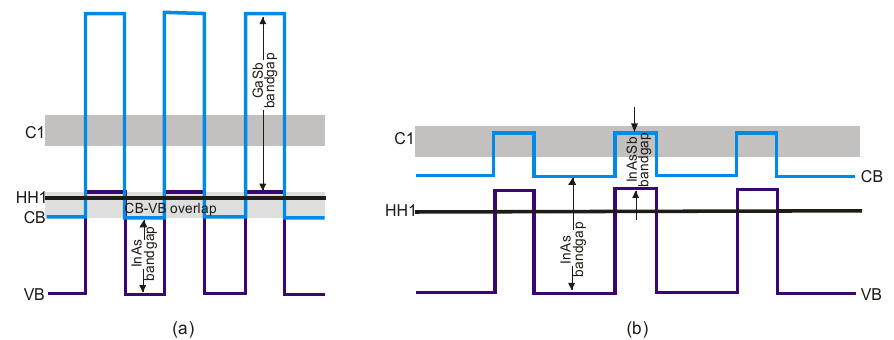
Figure 24. Bandgap diagram for ( a ) InAs/GaSb and ( b ) InAs/InAsSb T2SLs (after [106]).